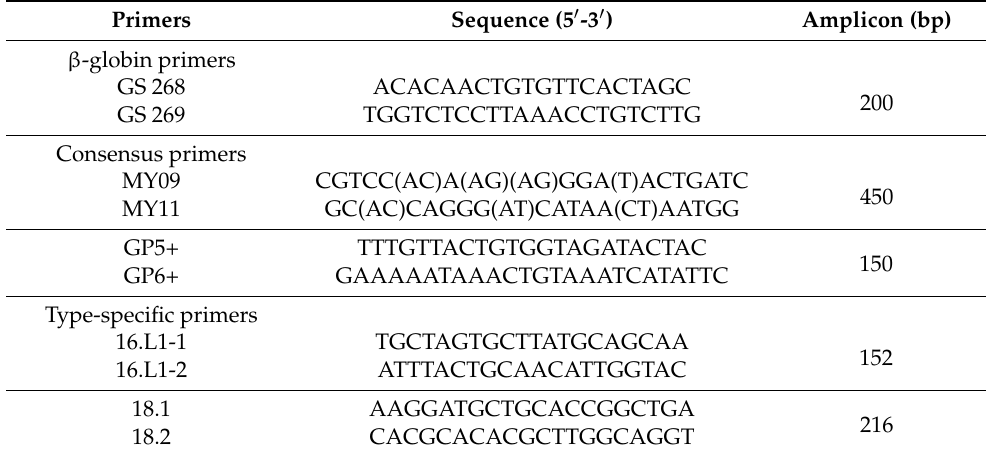
Table 2. Oligonucleotide primers used for HPV DNA